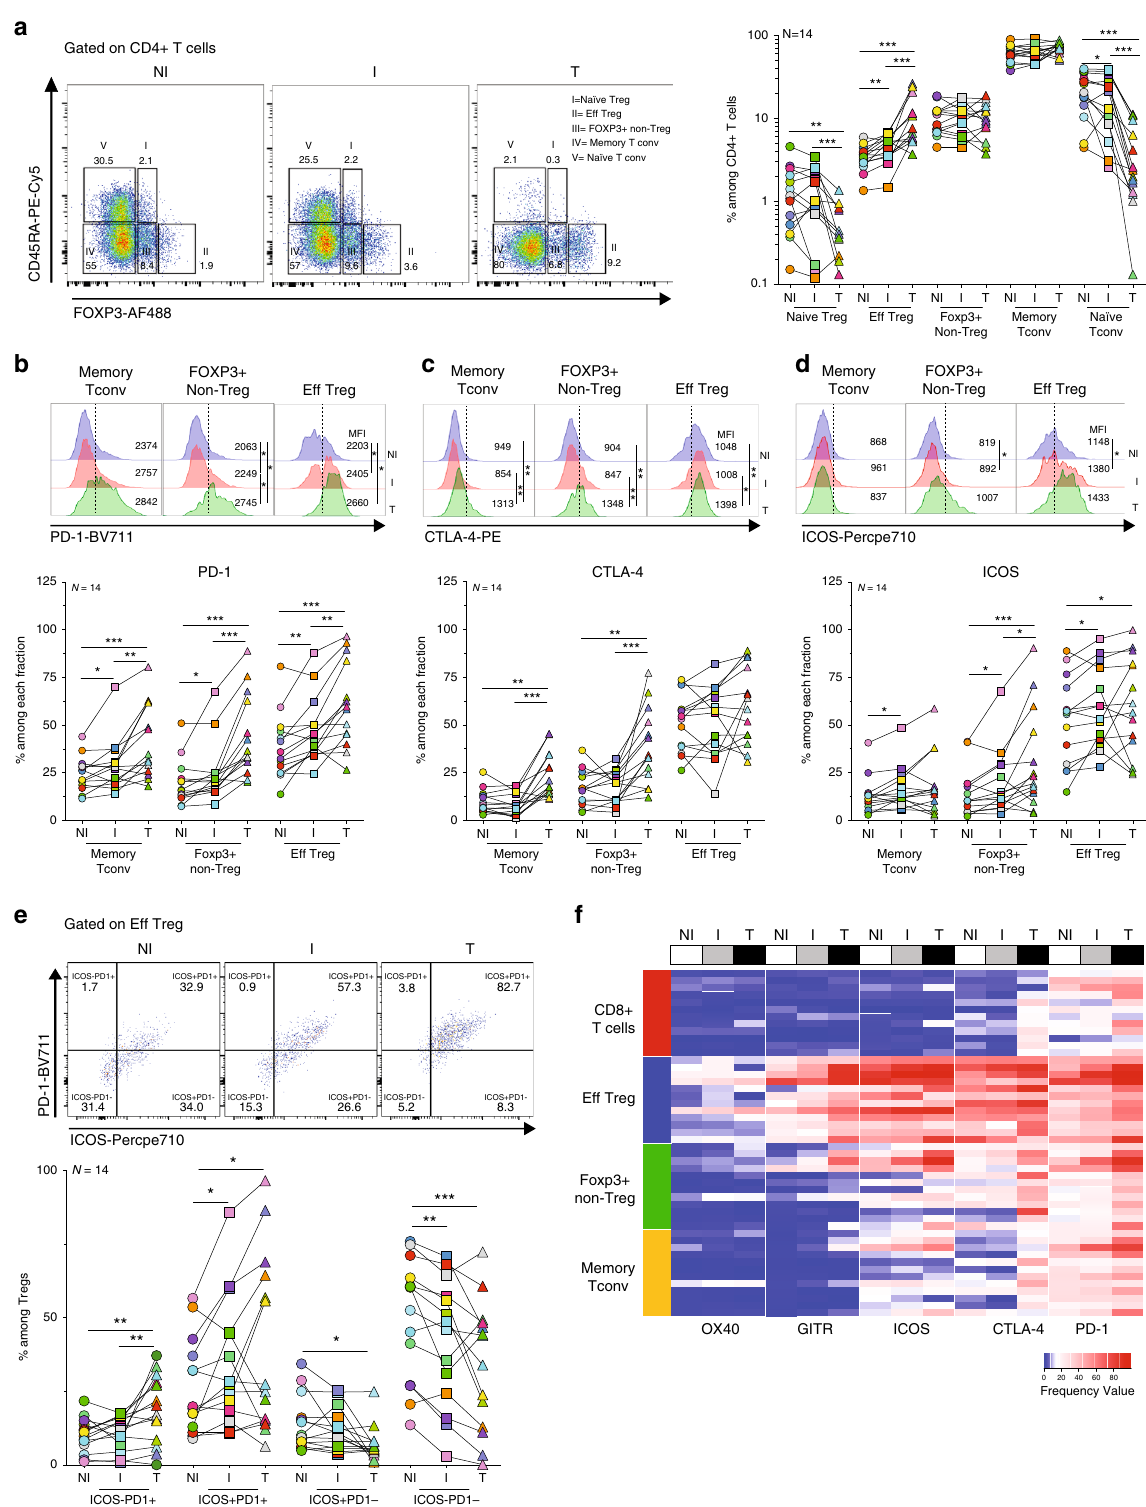
(ICOS, GITR, and OX40) and co-inhibitory (PD-1, CTLA-4) immune checkpoint molecules (Fig. 2b – e and Supplementary Fig. 2c – e). Also, Tregs showed the highest mean fl uorescence intensities (MFIs) values for ICOS, OX40, GITR, CTLA-4, and PD-1 (Supplementary Fig. 2a). Tregs also expressed the highest levels other Treg cell-associated molecules, such as Ki-67,